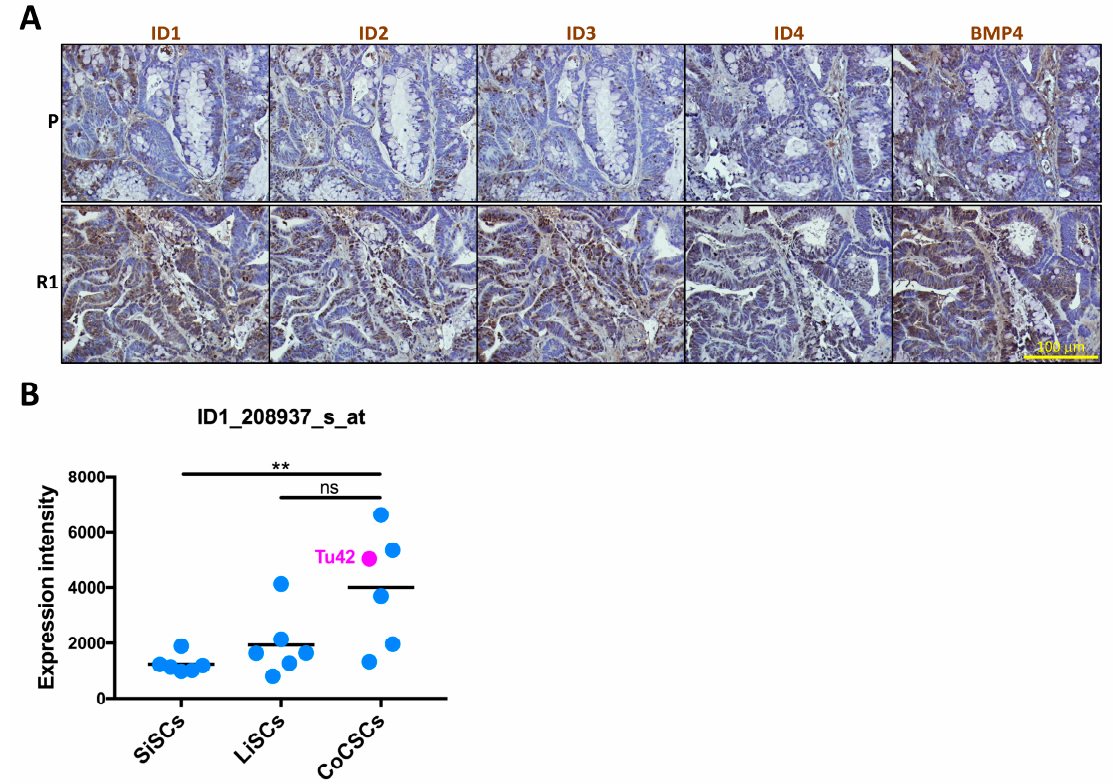
Figure 5. ID1-expressing cell enrichment is a feature of 5-FU resistant Tu42 cell-derived tumor xenograft. ( A ) PFA-fixed, paraffin-embedded serial sections of parental or R1 cell-derived tumor xenografts stained with ID1, ID2, ID3, ID4, or BMP4 antibodies (DAB, brown color). Pictures are representative of five histological stains per tumor. ( B ) Dot plot with line in the mean showing ID1 expression obtained from quantile normalized microarray datasets of short-term feeder-expanded normal small or large intestinal stem cells (SiSCs and LiSCs, respectively) and CRC stem cells (CoCSCs). Each dot represents one sample. (ns. p > 0.05; ** p ≤ 0.01).